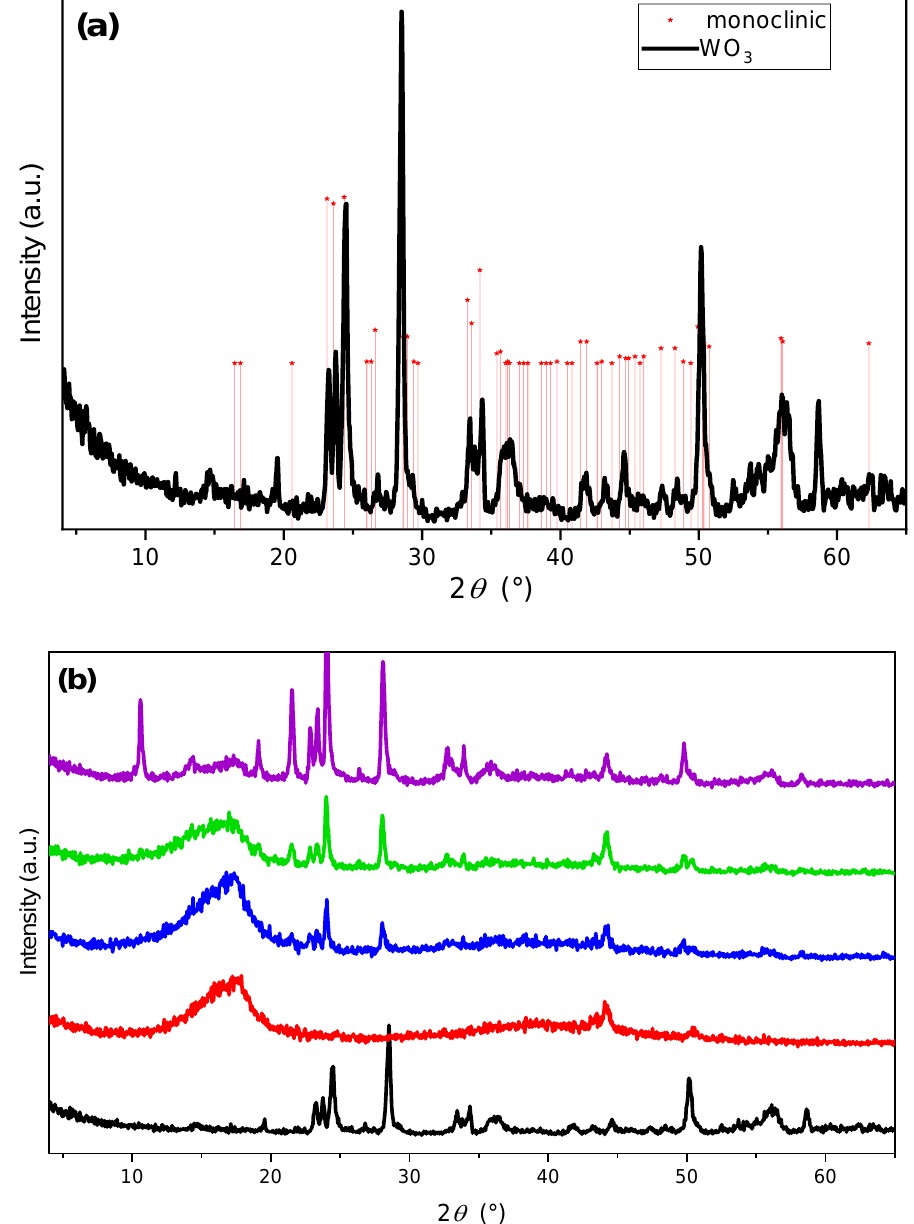
Figure 4. XRD patterns of the synthesised WO 3 ( a ) and the recast Nafion and hybrid membranes ( b ). Tungsten oxide (black), recast Nafion membrane (red), and Nafion membranes with 5, 10, and 15% tungsten oxide (blue, green, and purple, respectively). Marked with stars are the diffraction peaks from monoclinic WO 3 (JCPDS no.72-067 7). However, the membrane diffraction peaks totally changed after incorporating a higher amount of WO3 (15 wt.%). A new peak at around 2𝜃 = 10.6° can be observed,